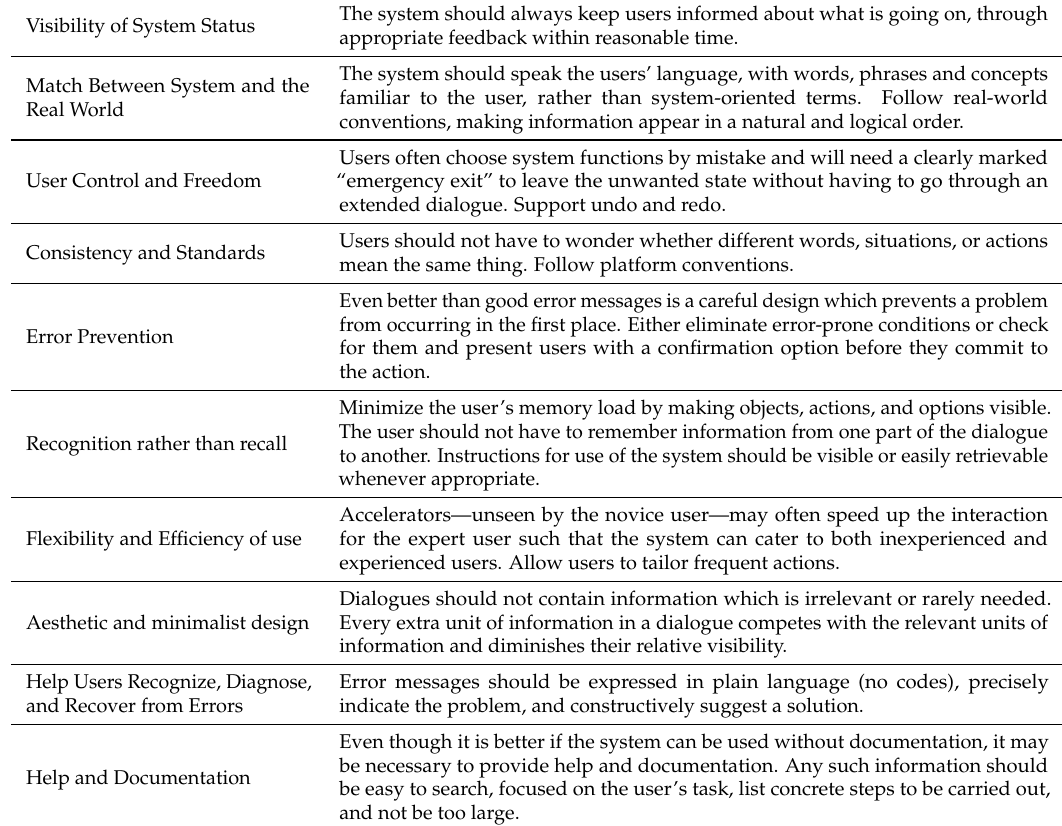
Table 1. Nielsen’s 10 principles and